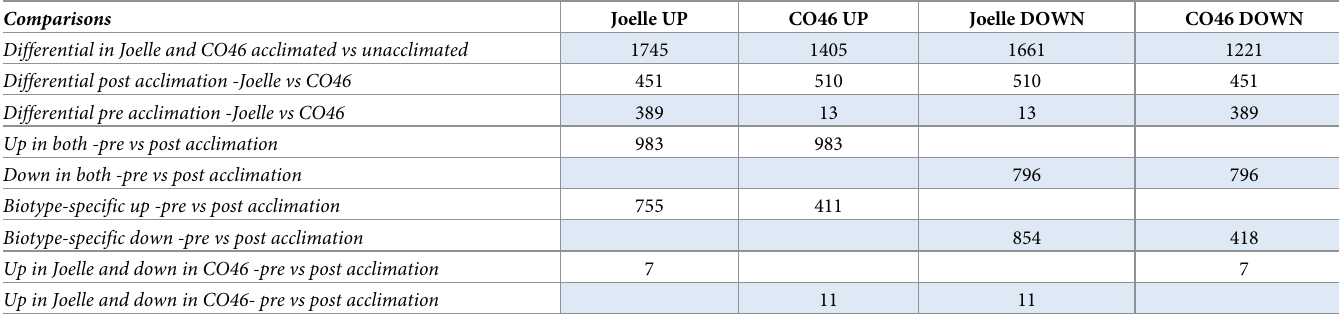
Table 2. Differentially expressed genes for indicated